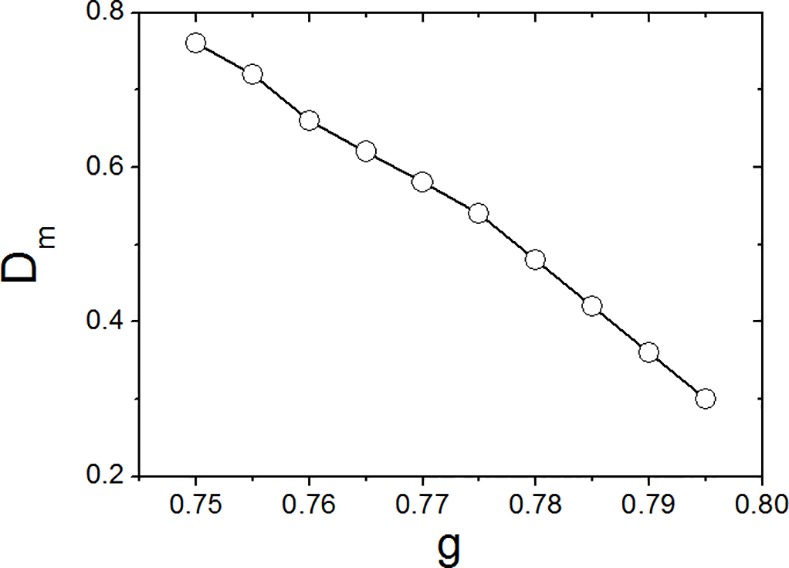
The relationship between the minimal noise intensity D
m and coupling strength g.